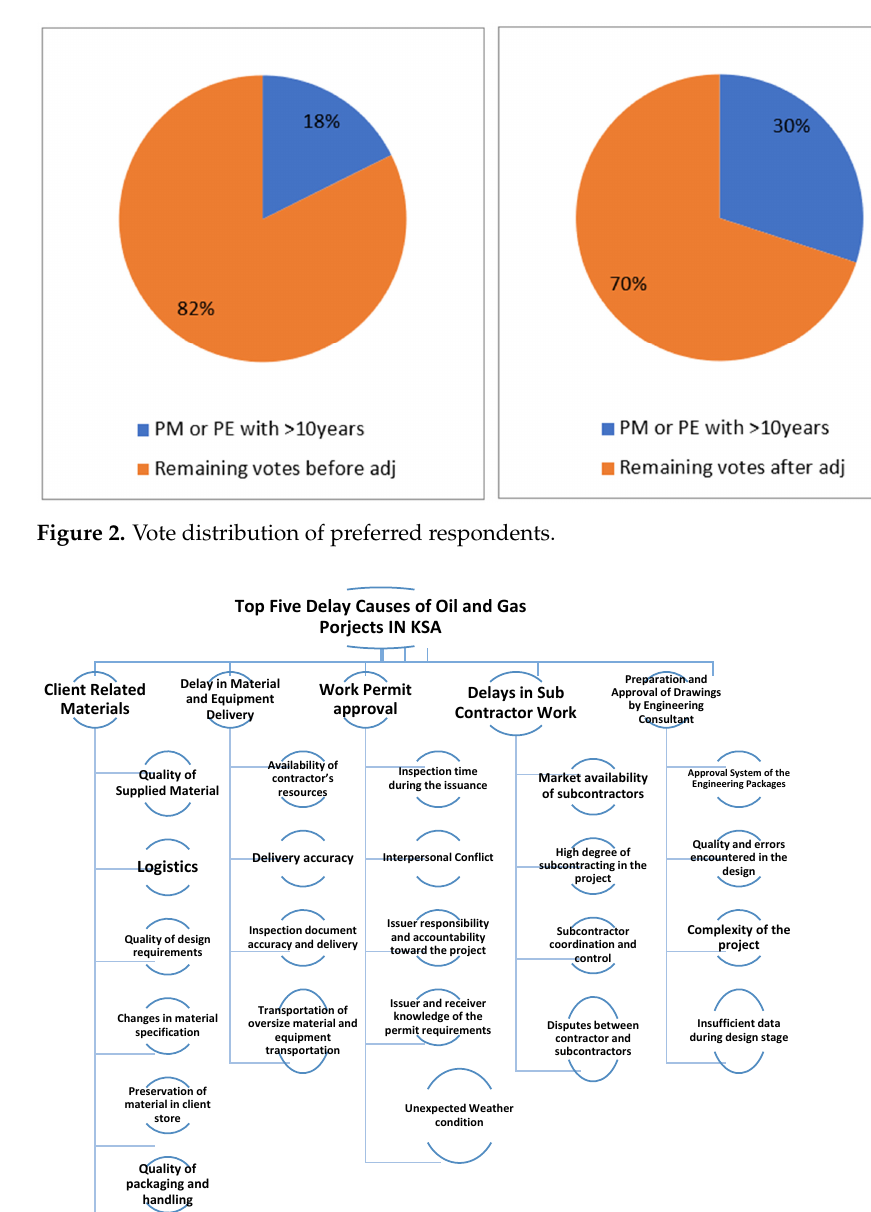
Table 6. Top ten causes from owner point of view.